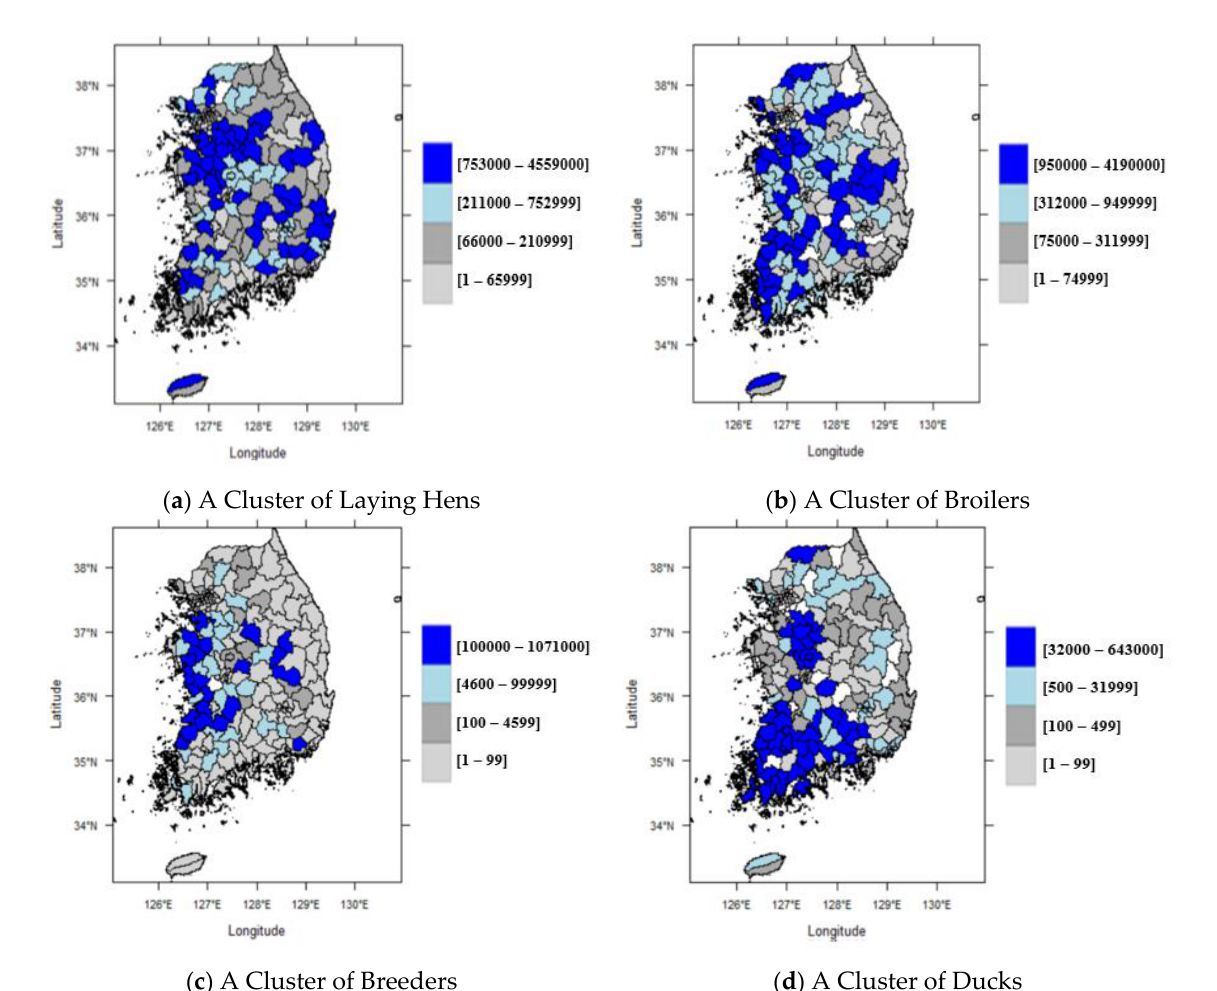
Figure 1. Spatial distribution of poultry numbers in Korea, 2016. Climatically, the mean values of temperature, precipitation, and relative humidity for all counties were 13.5 ◦ C, 112.2 mm, and 69.7%, respectively. For the main habitat of migratory birds, the average value across all counties was 0.2. The average number of livestock vehicle registration in all provinces was 301.7. For demographic and social factors, the average population growth rate in 2016 was 0.38%, while the average migration was 0 but ranged from − 14,030 to +43,530. The average population density was 1058 people per square kilometer, and the aging index, which represents the proportion of people over 65 years old, averaged 20.6%.